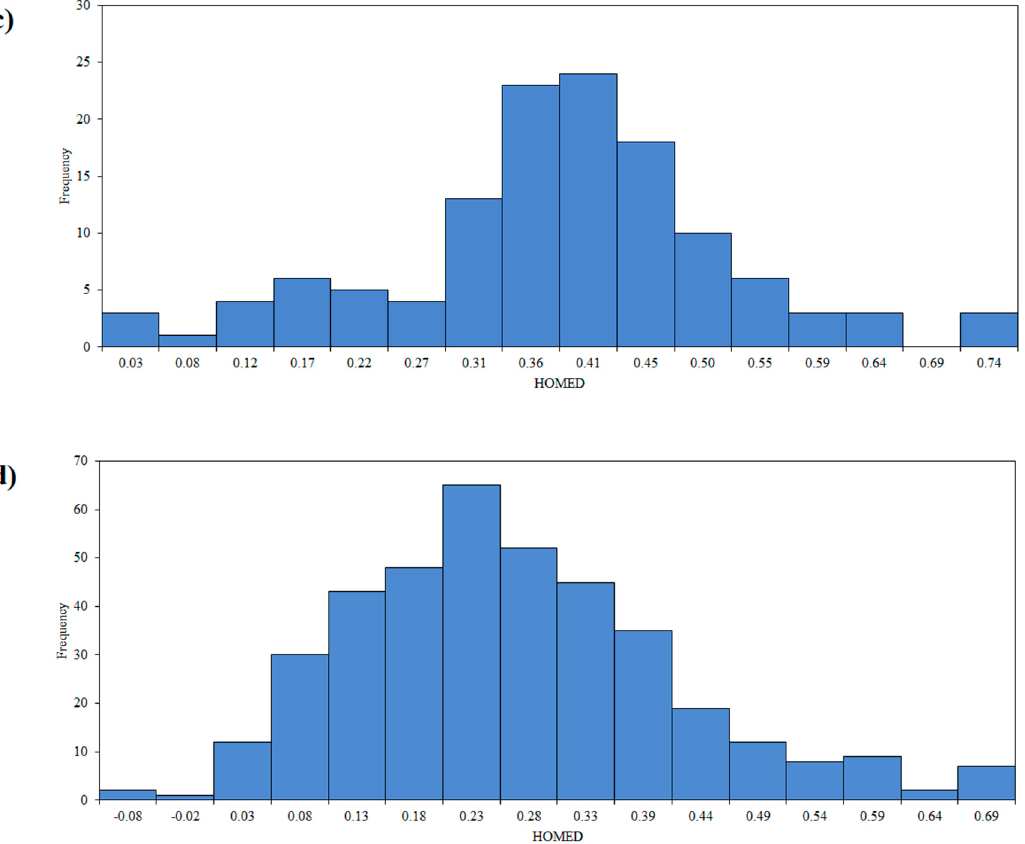
Figure 5. Histogram for the HOMED value for the middle ring of 5 H -dibenzo[b,f]azepine ( a ), 5 H -dibenzo[a,d][7]annulene ( b ) 10,11-dihydro-5 H -dibenzo[b,f]azepine ( c ) and 10,11-dihydro-5 H - dibenzo[a,d][7]annulene ( d ). Compound structures are taken from CSD crystal database.